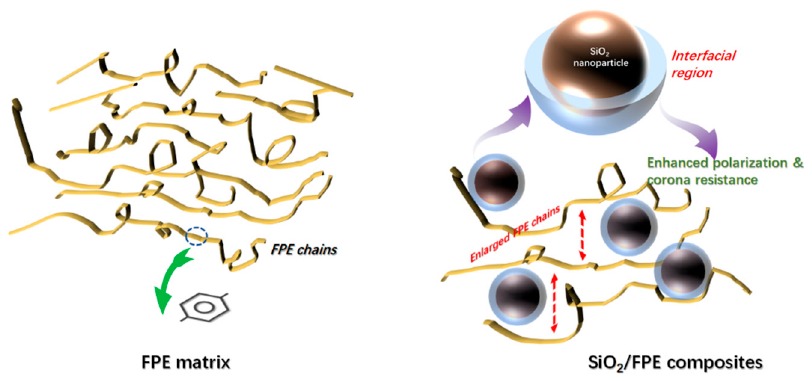
Figure 6. Schematic diagram of the role of SiO 2 particles in an SiO 2 /FPE composite film.